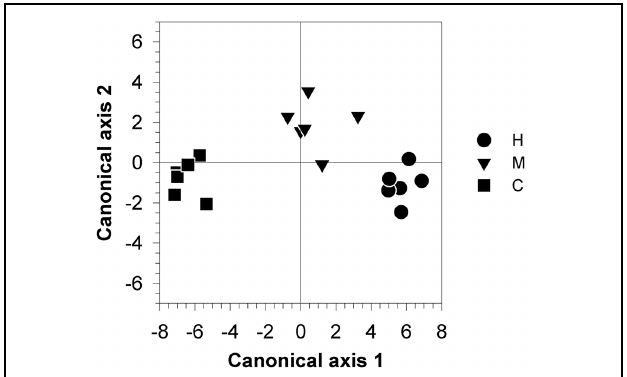
FIGURE 8 | Canonical discriminant analysis performed using variables representing the allocations to defense components and to non-structural (NCS) and structural (growth) carbon [RWC, total soluble sugars and starch (wood and leaves), β -phellandrene, δ -3-carene, and the number of monoterpenes and sesquiterpenes, total number of cells (A) and rate of growth (cell.day − 1 )] collected from 18 trees belonging to three different defoliation intensities (H, heavily defoliated trees; M, moderately defoliated trees; C, control trees).